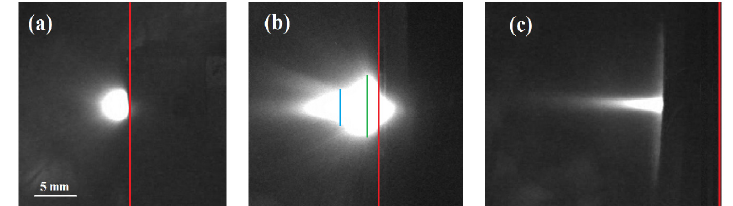
Figure 8. Photographs of the thruster plume (white region) at different magnetic induction values, red line indicate the anode plane (in Figure 8c the red line is near the right edge of the image). No coil case ( a ) and two cases with assembled magnetic coil: B = 0.12 T ( b ) and B = 0.25 T ( c ). Blue and green lines in ( b ) represent a selected plume diameter.